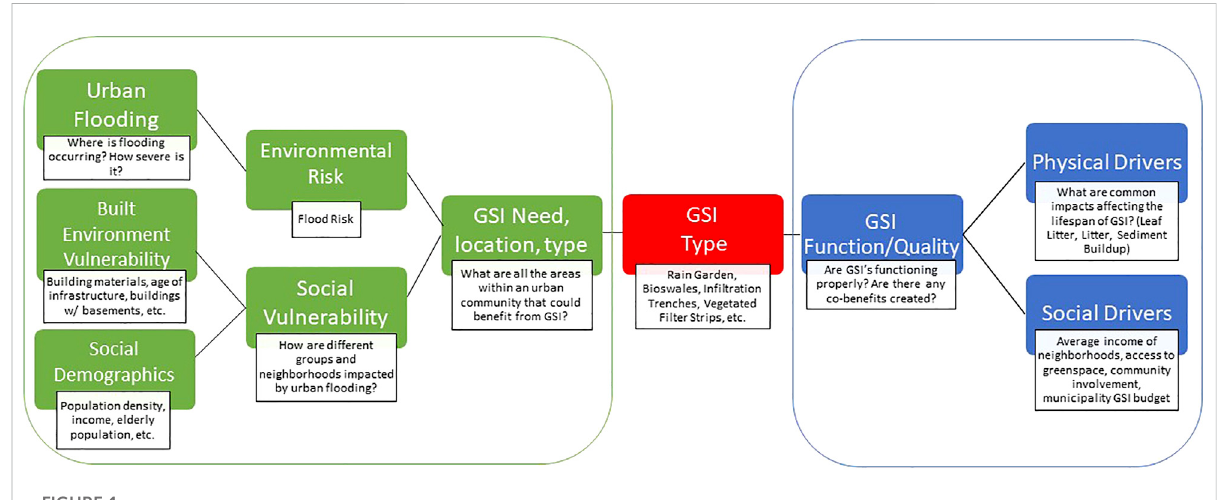
FIGURE 1 A work fl ow for getting to the question of ‘ How can cities implement GSI in an equitable manner that considers not just neighborhood vulnerabilities and need for GSI, but also the potential limitations and bene fi ts associated with the GSI that are implemented? ’